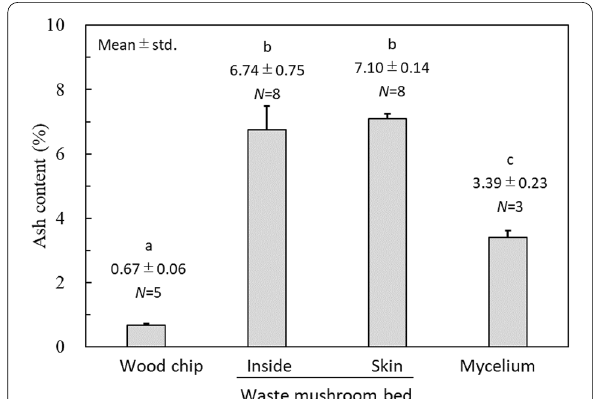
Fig. 4 Results of the ash content tests. Means with different letters are significantly different at P 0.05 (Welch’s t =